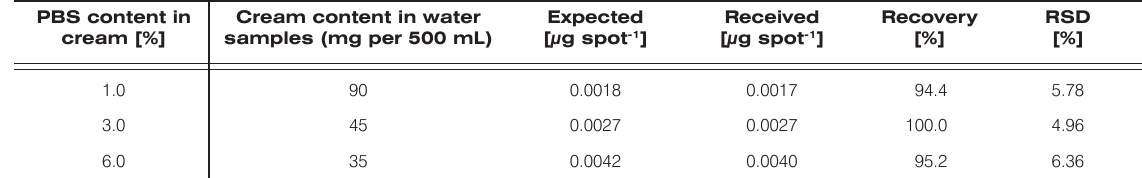
Table 3. Recovery tests (n=3) for residual PBS in tap water samples containing SLS. Application volume – 1 μL spot -1 . PBS content in Cream content in water cream [%] samples (mg per 500